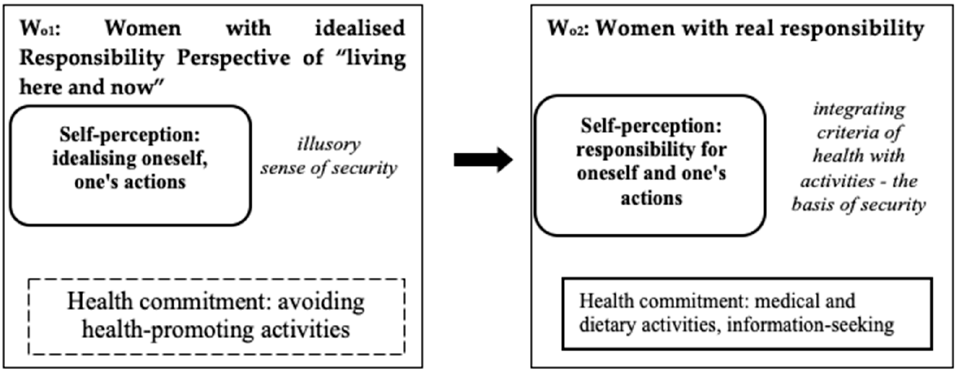
Figure 2. Two sub-models (Wo 1 , Wo 2 ) that illustrate the transformation of responsibility for one’s health: from idealized responsibility to real responsibility. health: from idealized responsibility to real responsibility.